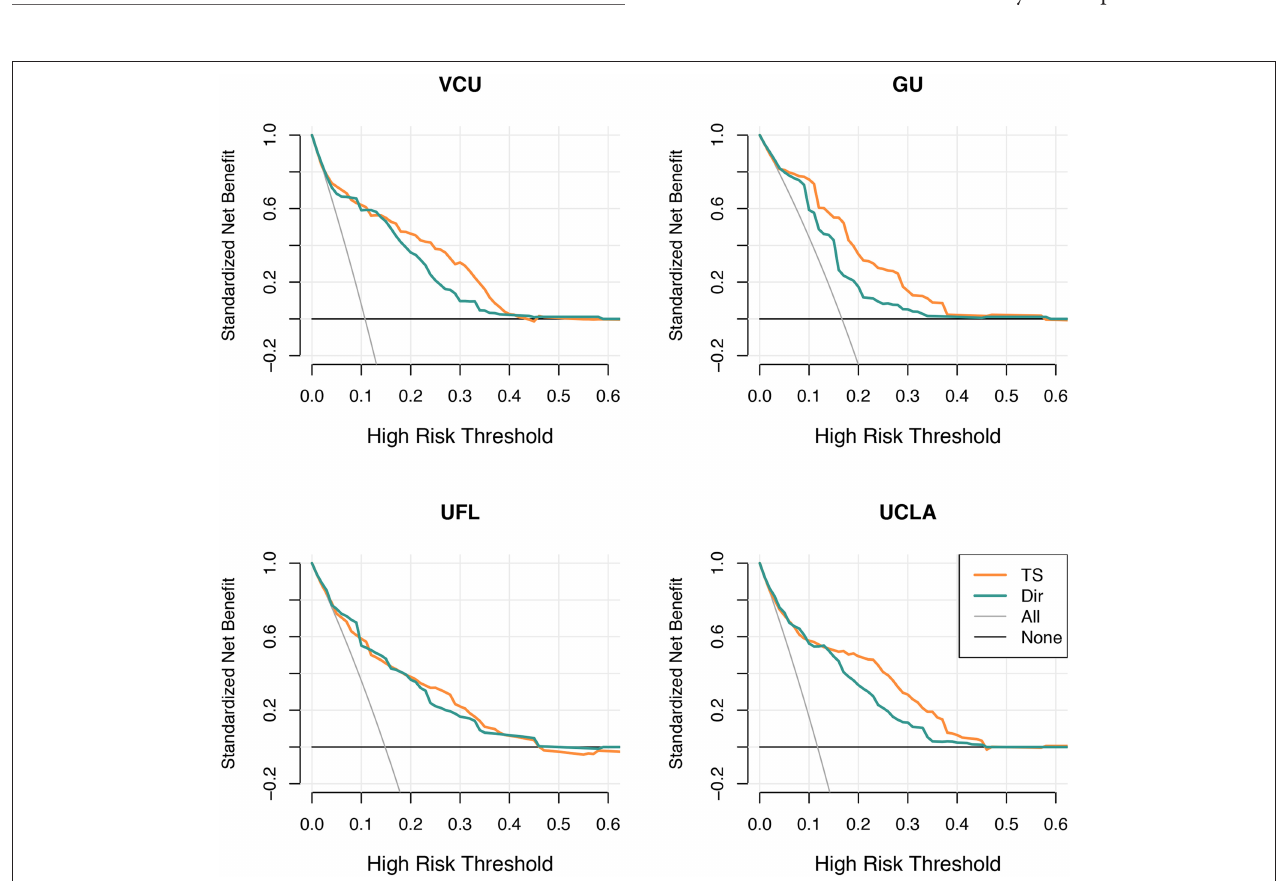
FIGURE 4 | Decision curve analysis plots for a comparison of net benefits at different risk thresholds between the two-step (orange line) method and the direct one-step (green line) method.